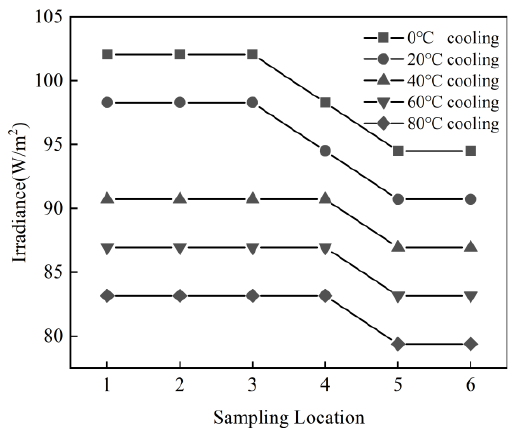
Figure 4. Irradiance of the UV-LED array at 6 positions under cooling water temperatures is 0, 20, 40, 60, and 80 °C, respectively.